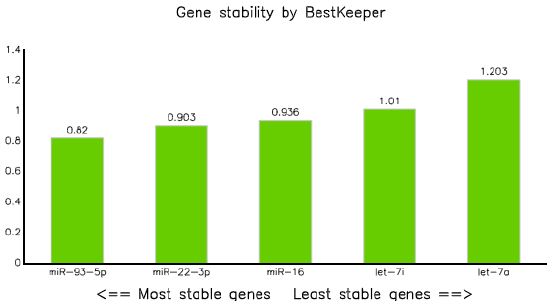
Figure 4. Gene stability result of selected miRNAs performed by BestKeeper.